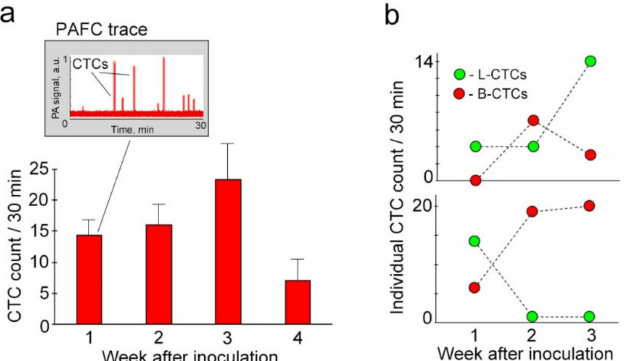
Figure 6. Parallel dissemination of blood CTCs (B-CTCs) and L-CTCs. ( a ) Average counts of B-CTCs (mean ± SEM) in groups of mice at week 1 ( n = 33), week 2 ( n = 21), week 3 ( n = 15) and week 4 ( n = 6) after inoculation; inset; 30-min PAFC trace from the ear artery in the mouse with early melanoma (week 1 after inoculation). ( b ) Representative examples of individual interrelations between L-CTCs and B-CTCs over disease